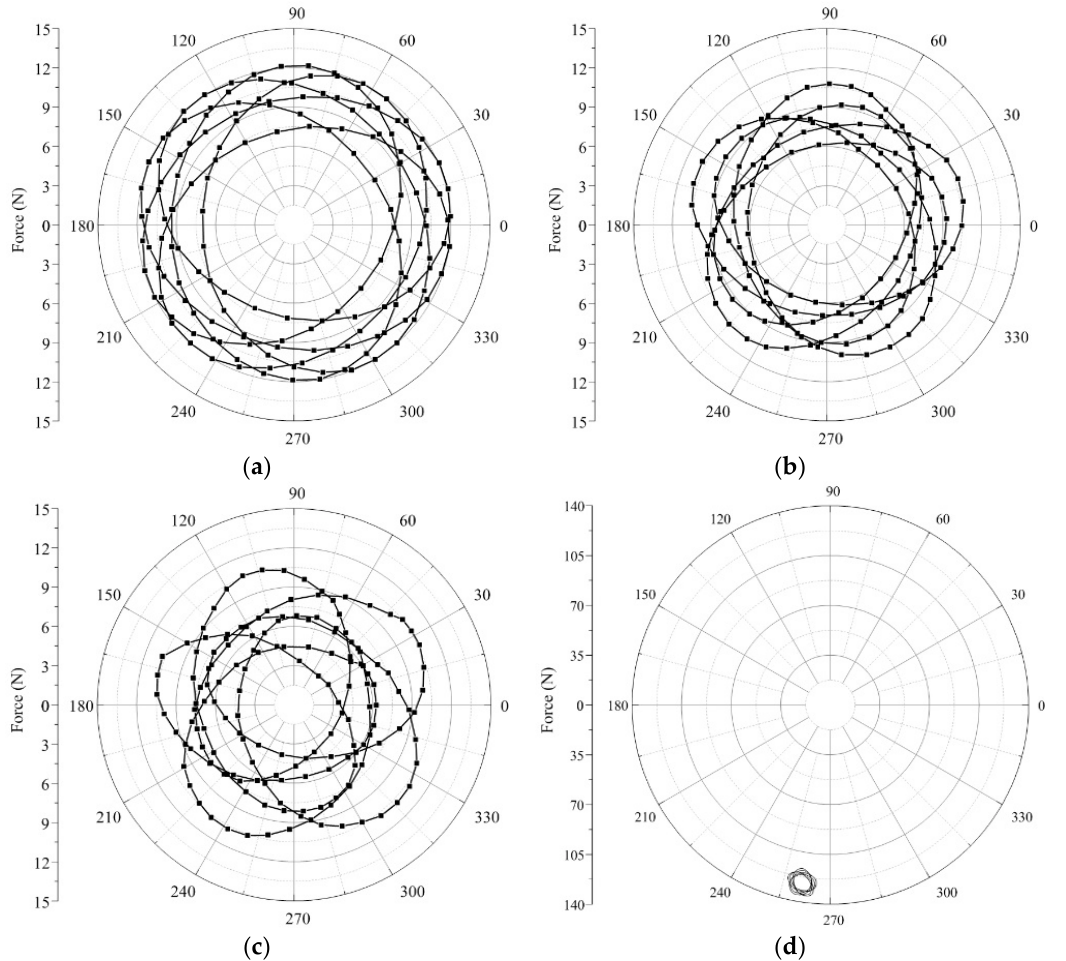
Figure 30. Radial force trajectory on principle axis for different tip clearances: ( a ) 0 mm × 5; ( b ) 1 mm × 5; ( c ) 2 mm × 5; ( d ) 1 mm × 4 + 2 mm × 1 [76].